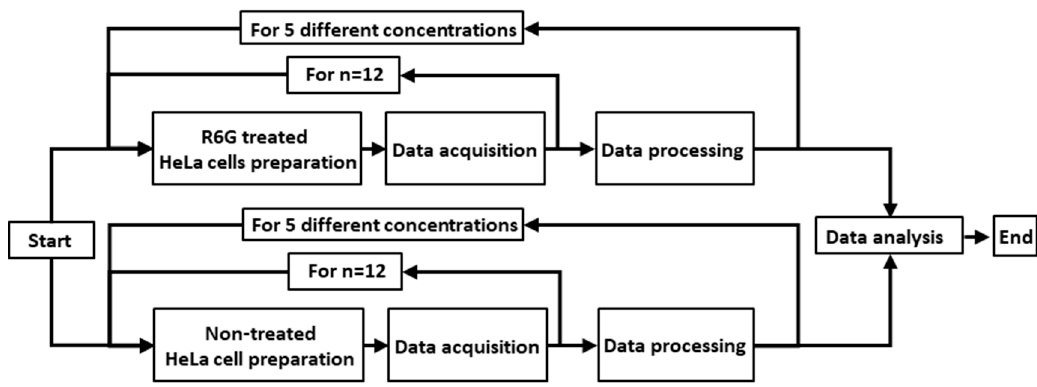
Figure 5. Data acquisition procedure of fluorescence detection system for a single filter set and load resistor.